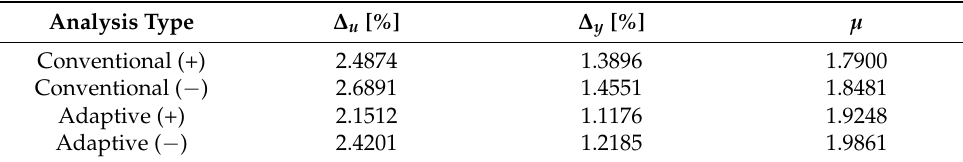
Figure 9. Resulting capacity and idealized curves obtained from adaptive pushover analysis: ( a ) lateral forces (+) and ( b ) lateral forces ( − ). Table 5. Ductility values obtained from the idealized capacity